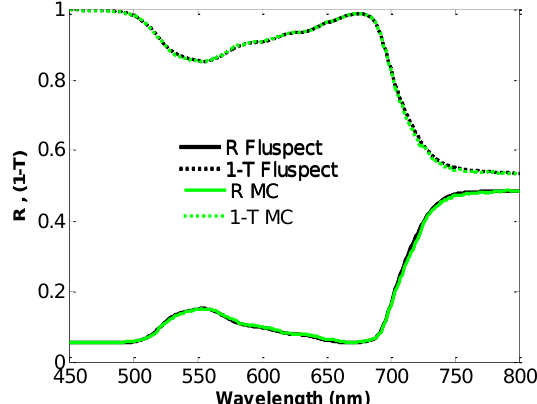
Figure 7. The simulated leaf reflectance and transmittance by the MC model and the Fluspect model